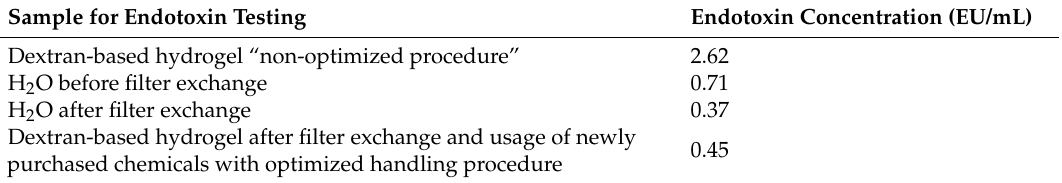
Table 1. Endotoxin concentration of dextran-based hydrogels and utilized H 2 O. Sample for Endotoxin